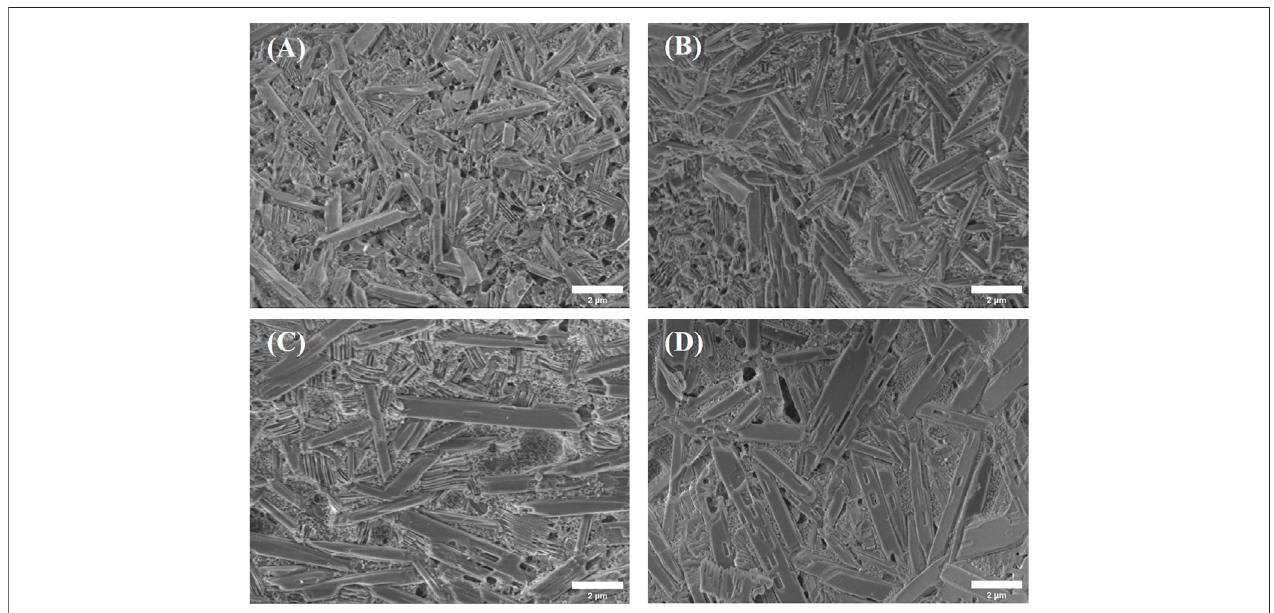
FIGURE 3 | SEM images of the Li 2 Si 2 O 5 glass-ceramics with different compositions: (A) LDW0; (B) LDW1; (C) LDW3; and (D) LDW5.